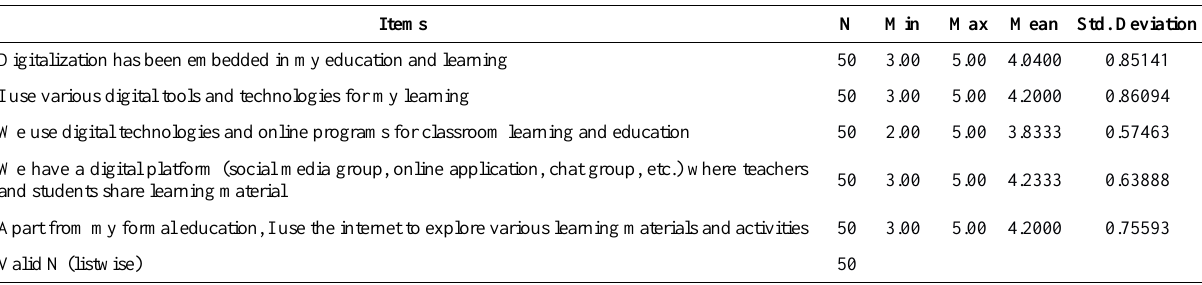
Table 2. Descriptive statistics for the digitalization of additional